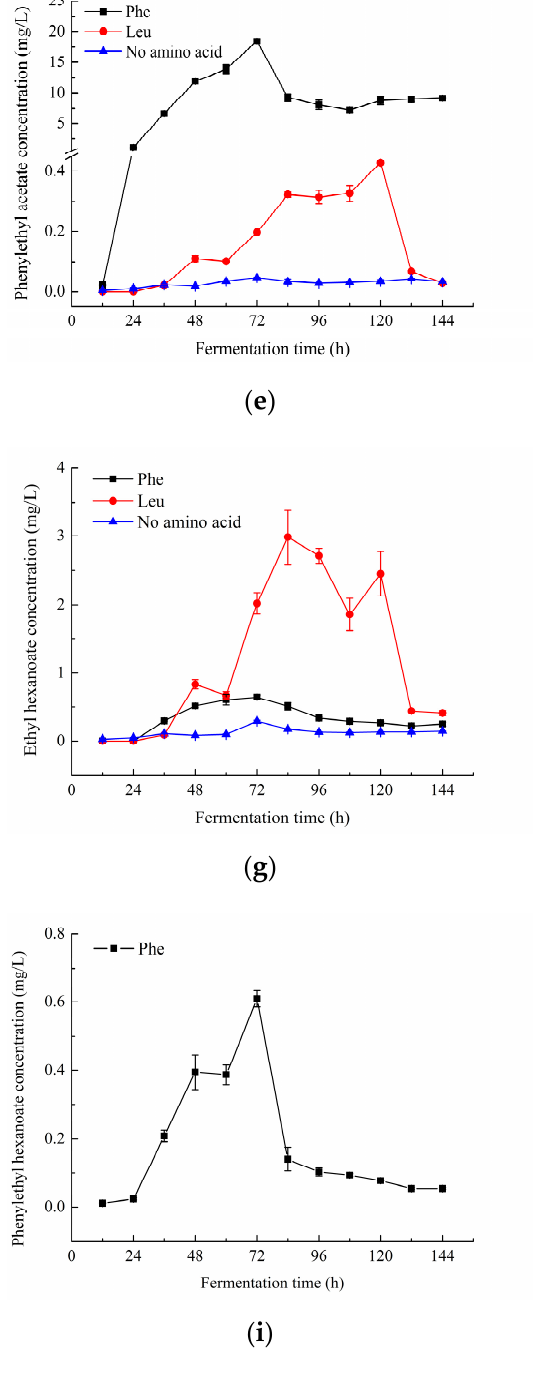
Figure 2. The changes in the content of the same characteristic aroma compound during fermentation in the simulated juice systems with/without the addition of amino acids: ( a ) phenylethyl alcohol; ( b ) isoamyl alcohol; ( c ) 1-pentanol; ( d ) octanoic acid; ( e ) phenylethyl acetate; ( f ) isoamyl acetate; ( g ) ethyl hexanoate; ( h ) ethyl caprylate; ( i ) phenylethyl hexanoate; ( j ) phenyl caprylate.